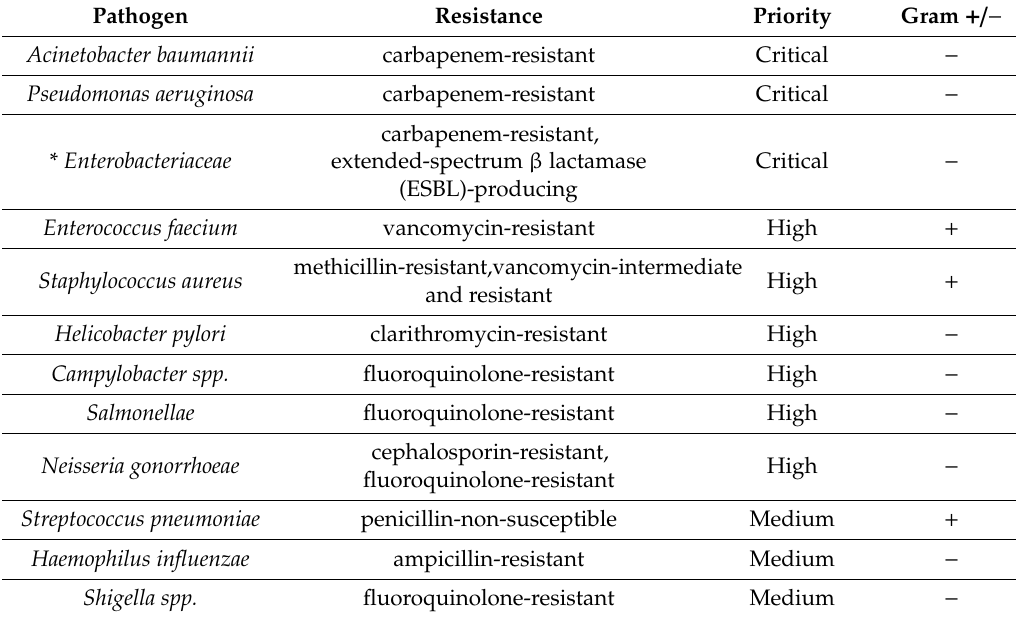
Table 1. Priority pathogens published by the World Health Organization (WHO) in 2017. The table summarizes the antibiotic classes and their mechanisms of resistance. * Enterobacteriaceae includes